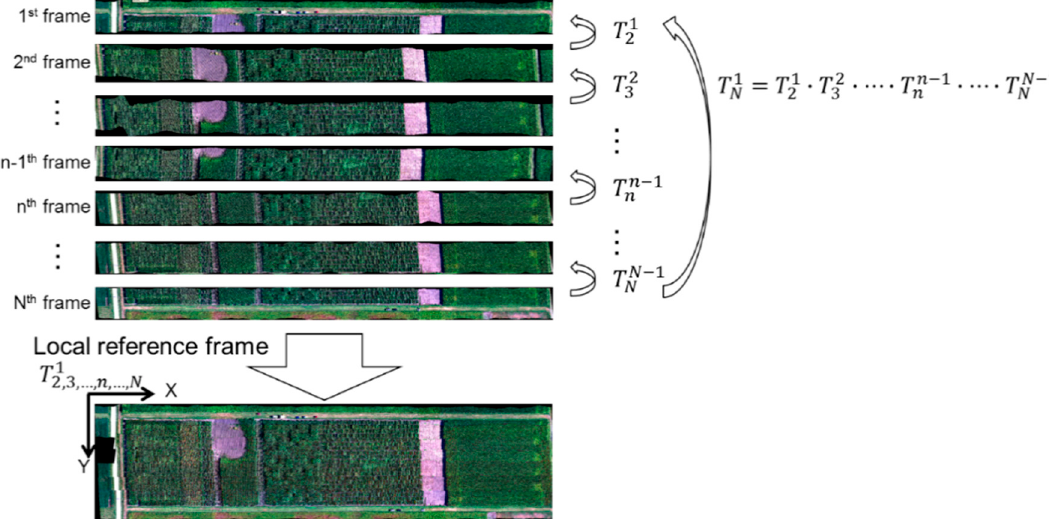
Figure 6. Conceptual basis of the implemented procedure for describing the geometric transformations between neighboring partially-rectified hyperspectral